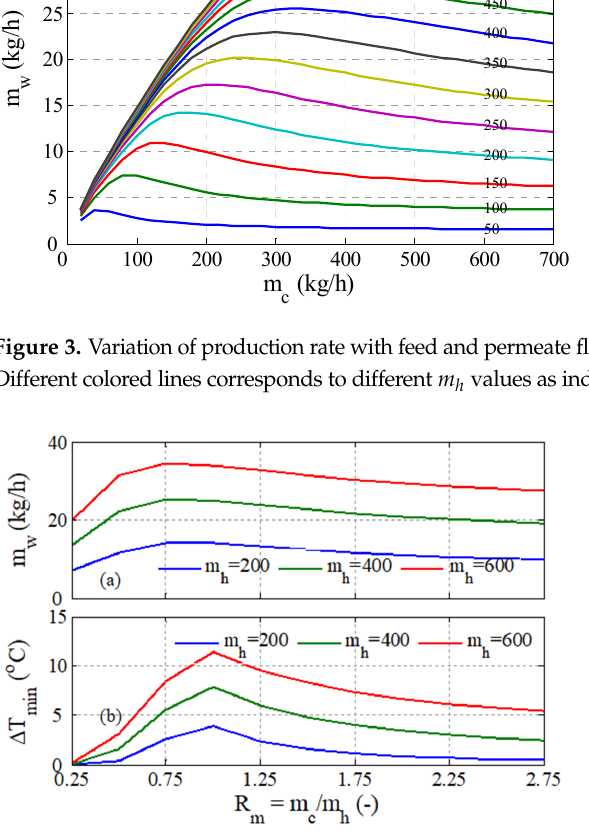
Figure 4. Effect of flow rate ratio on the steady state water production and minimum temperature = 80 (cid:2925) C ; ( a ) water production, ( b ) minimum temperature difference at 𝑇 (cid:3035) (cid:3284)(cid:3289)